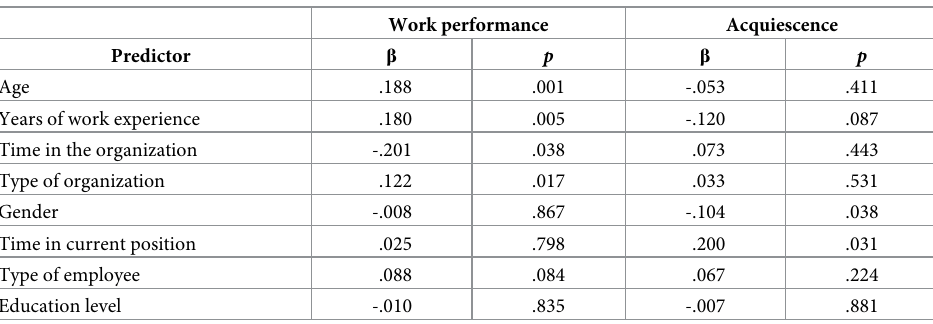
Table 5. Results of the predictive model